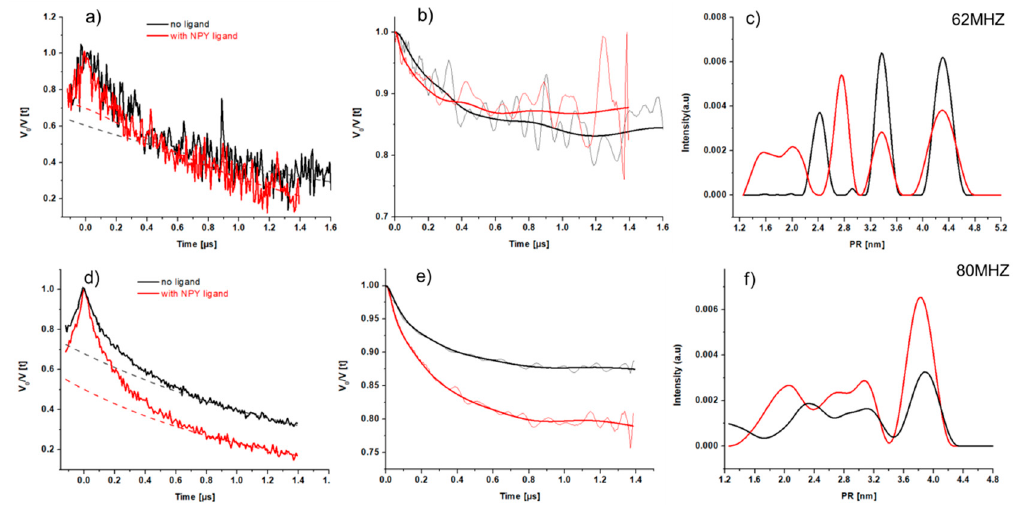
Figure 8. DEER measurements of the Y 2 R at different offsets in the presence and absence of ligand NPY at 50K. From left to right are given DEER raw data (left) with applied background lines dashed lines), background corrected DEER time traces with their fit (solid line) (in center) and the corresponding distance distributions (right). The upper panel shows the DEER data measured at 62 MHz ( a – c ). The DEER data at 80 MHz offset are given in the lower panel ( d – f ).